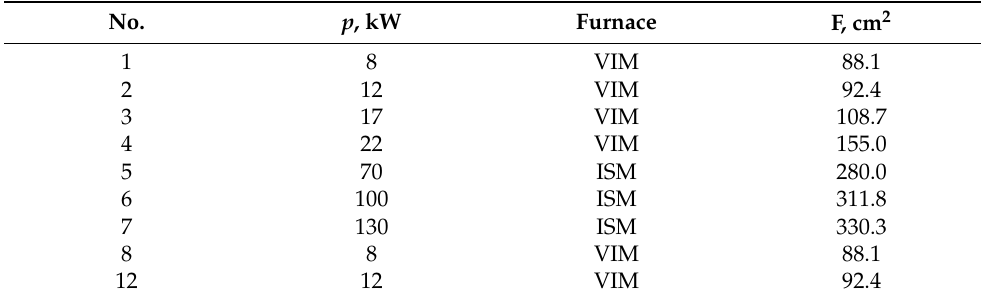
Table 4 summarises the values of the meniscus surface area estimated for all experi- ments using the proposed calculation method. Table 4. Values of the surface area of meniscus formed for Al-Zn alloys, estimated with the use of the proposed calculation method.